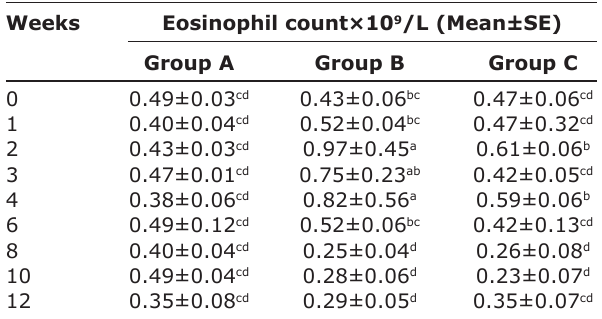
Table-11: Eosinophil count in female goat’s postinoculation with C. pseudotuberculosis and